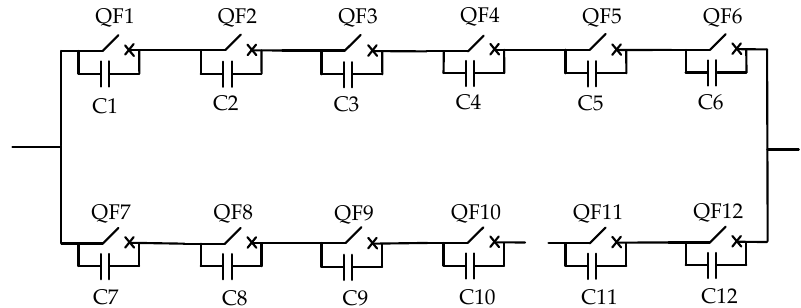
Figure 1. Topology of a 363 kV sextuple-break vacuum circuit breaker (VCB). Notes: QF means VCB; C means grading capacitor.